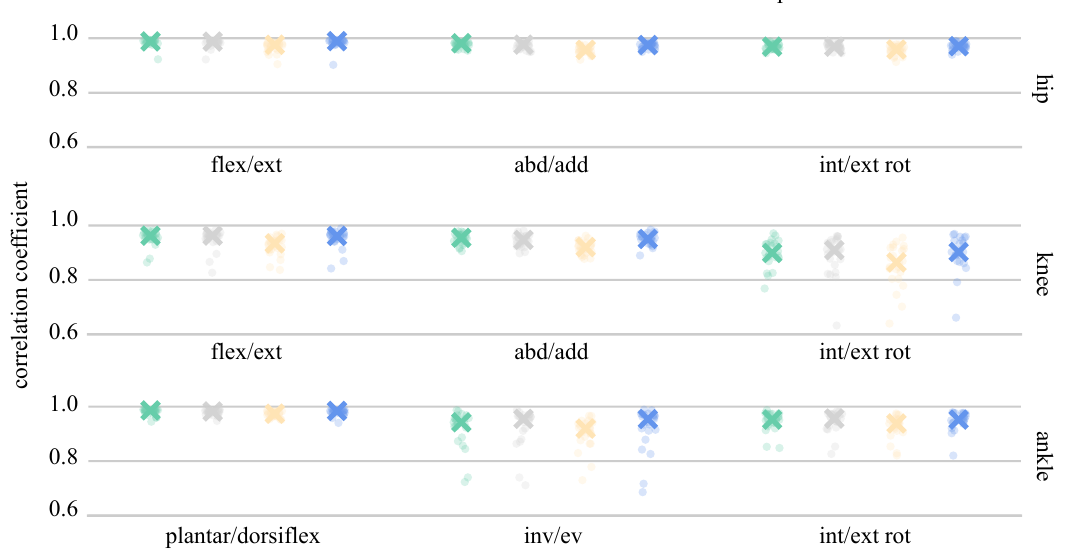
Figure 9. Median and single LOSO validation results of the correlation coefficient for the prediction of joint